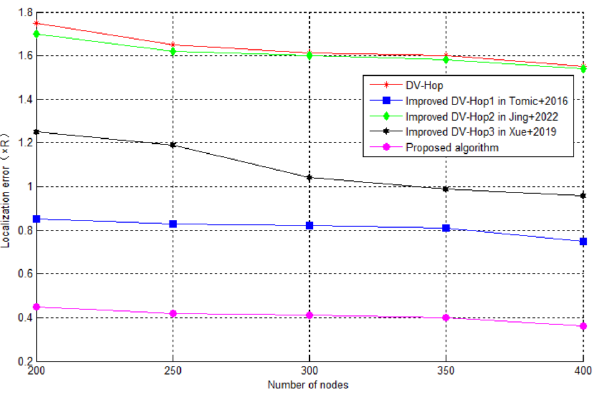
Figure 11. Comparison of localization errors of different total number of nodes [21][22][23].